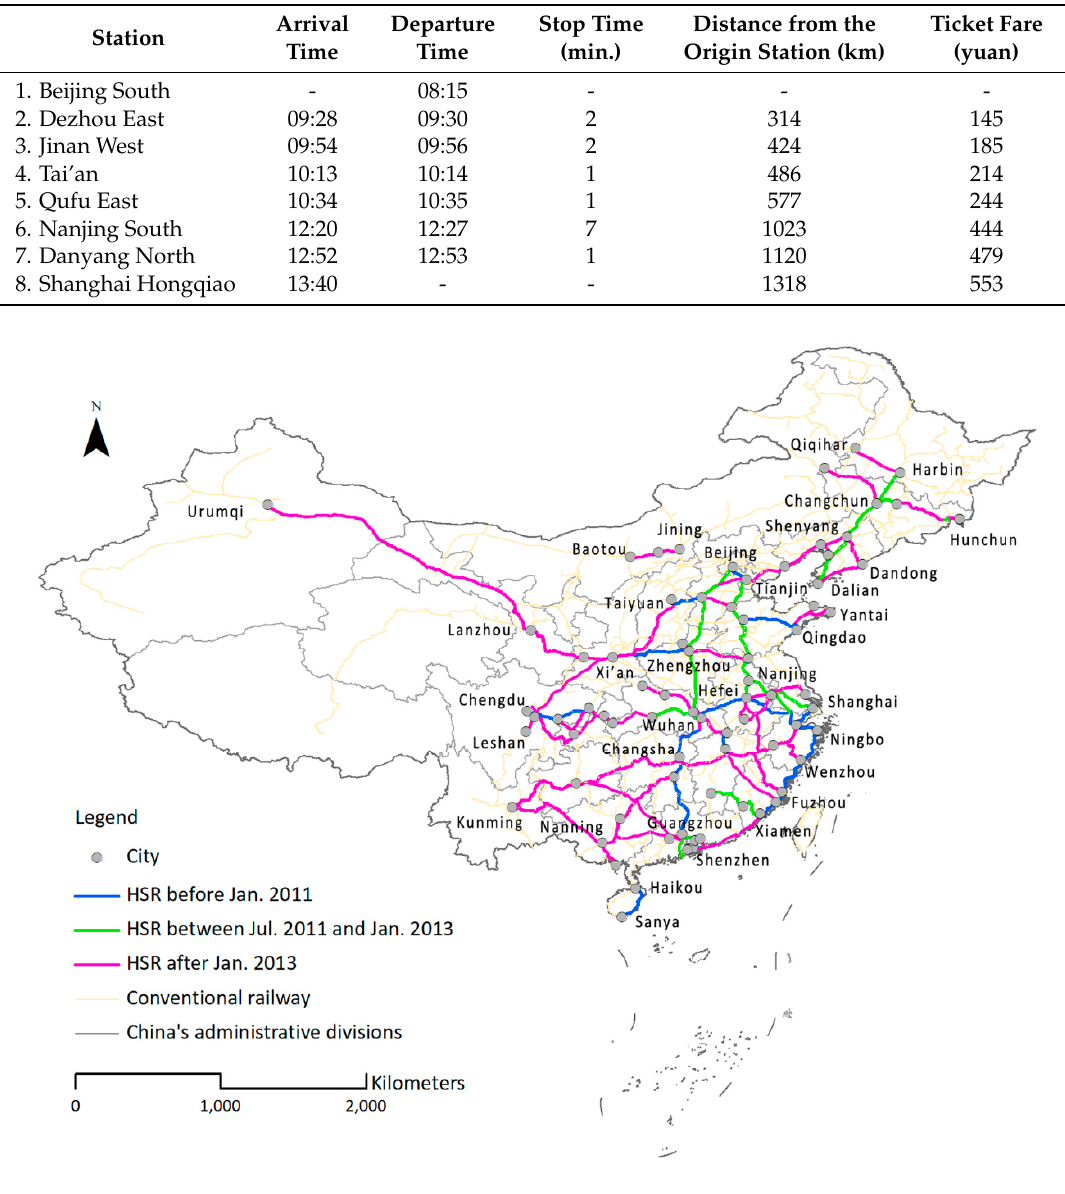
Table 3. Timetable of train route G107 in the Stage 2.